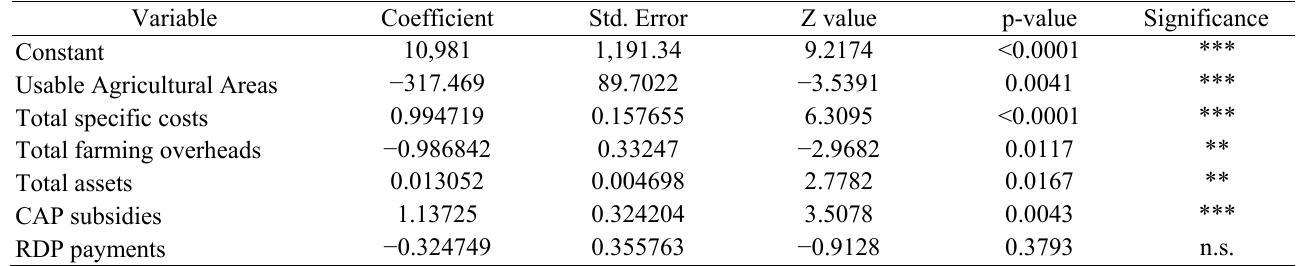
Main findings in the multiple regression model estimated by the ordinary least square. Dependent variable farm net income (Source: author’s elaboration on data